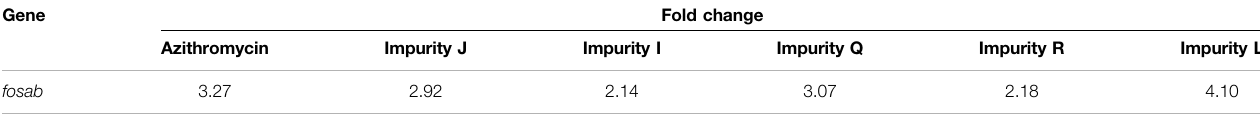
TABLE 4 | Fold-change of zebra fi sh fosab gene upregulated by azithromycin and its impurities J, I, Q, R, and L in RNA-seq analysis.